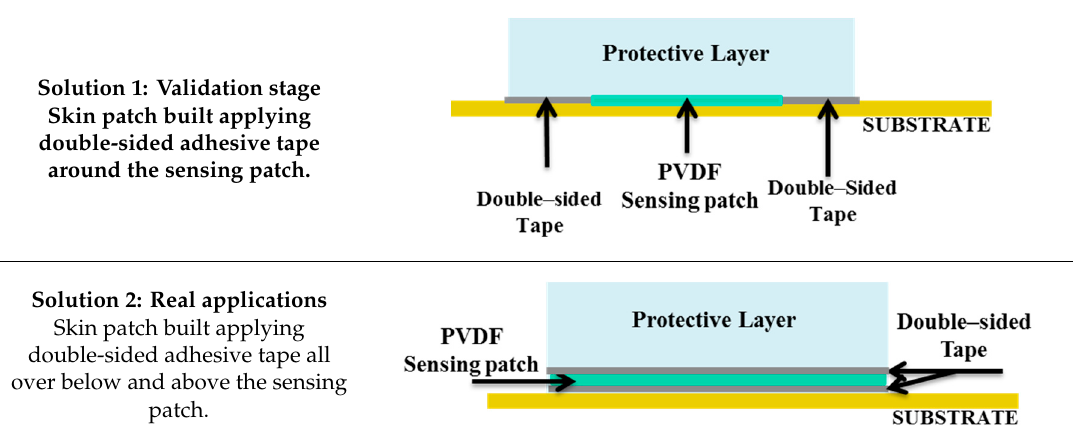
Table 3 . Illustration of different coupling methods .